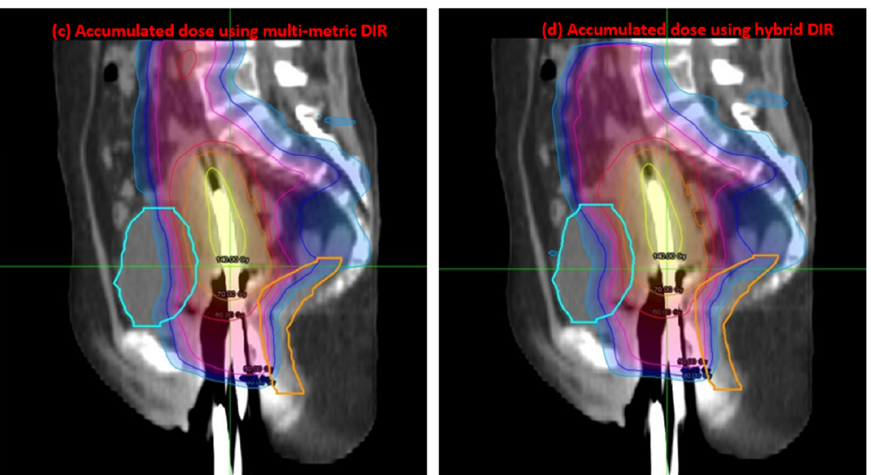
Figure 5. The registration results ( a , b ) achieved by the multi ‐ metric and hybrid DIR methods, respectively, and their corresponding accumulated dose distributions ( c , d ) for one patient. The reference bladder, rectum, and U + V are shown in cyan, orange, and red, respectively, and the corresponding deformed contours are shown in blue, yellow, and pink, respectively.